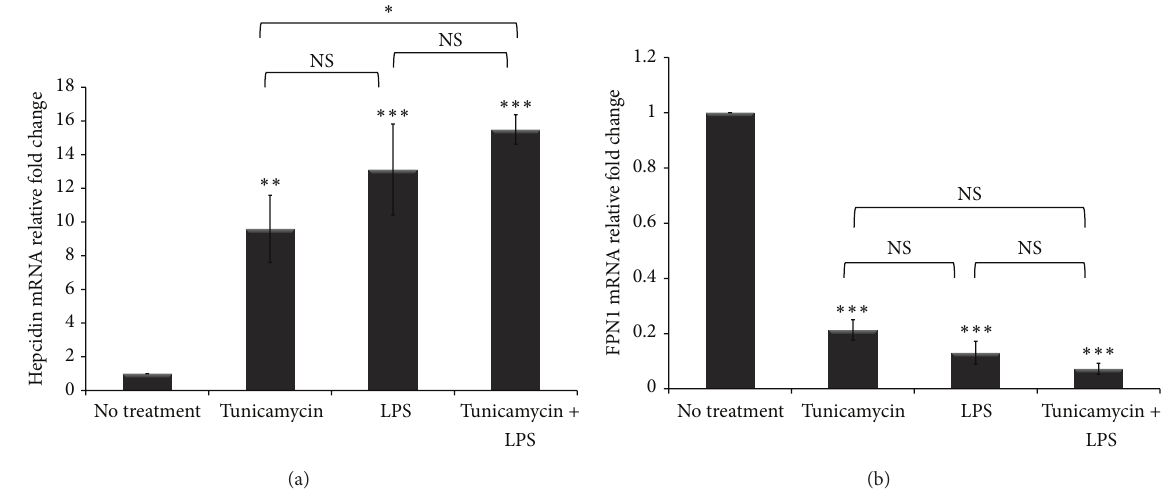
Figure 3: ER stress and inflammation dysregulate cellular iron homeostasis. THP-1 cells ( 1 × 10 6 cells/mL) were treated with tunicamycin (10 𝜇 g/mL) or DMSO overnight prior to LPS exposure (40ng/mL) for 6hr. ((a), (b)) Hepcidin and ferroportin (FPN1) gene expression was assessed by quantitative RT-PCR normalized to 𝛽 -actin. The fold change in hepcidin and FPN1 gene expression was calculated in reference to DMSO treated control THP-1 cells using the ΔΔ CT method and presented here normalized to no treatment control. Error bars represent the SD from the mean of three independent experiments. 𝑃 values were calculated in reference to vehicle (DMSO) treatment control using one-way ANOVA followed by Bonferroni multiple comparisons post hoc analysis. 𝑃 values annotated ∗∗∗ 𝑃 < 0.0001 ; ∗∗ 𝑃 = 0.001 – 0.0 1; ∗ 𝑃 = 0.01 – 0.05 ; 𝑃 > 0.05 were not significant (NS).